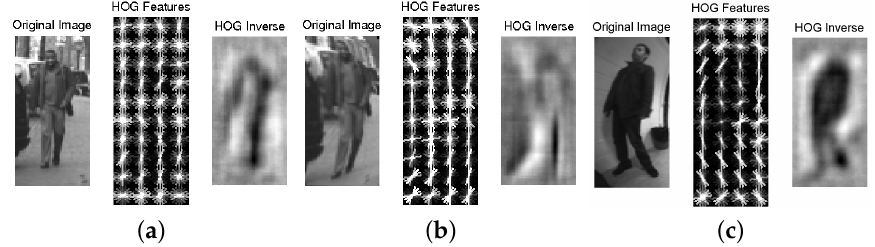
Figure 11. HOG features visualization in artificial distorted image samples. ( a , b ) The original 48 × 96 training sample image and its distorted version; ( c ) original distorted image sample captured by a fisheye